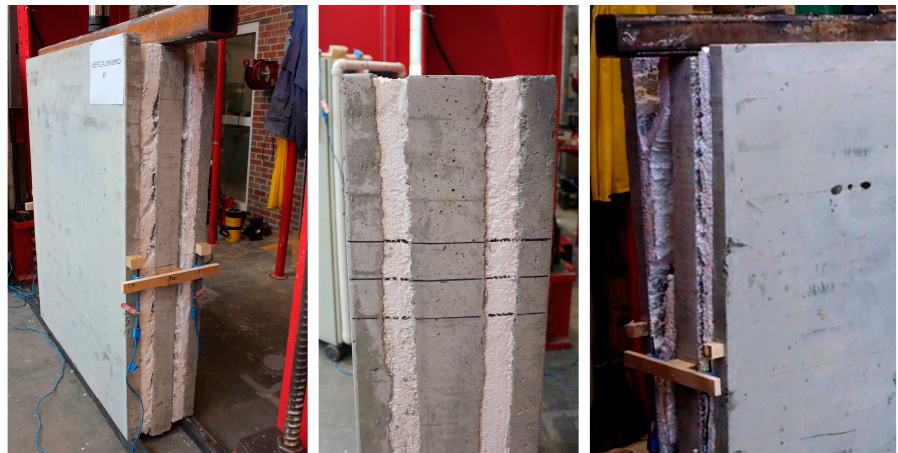
Figure 7. Panels EPS.24.2.MMGRID.1 ( left ), 2 ( middle ), and 3 ( right ) after testing.